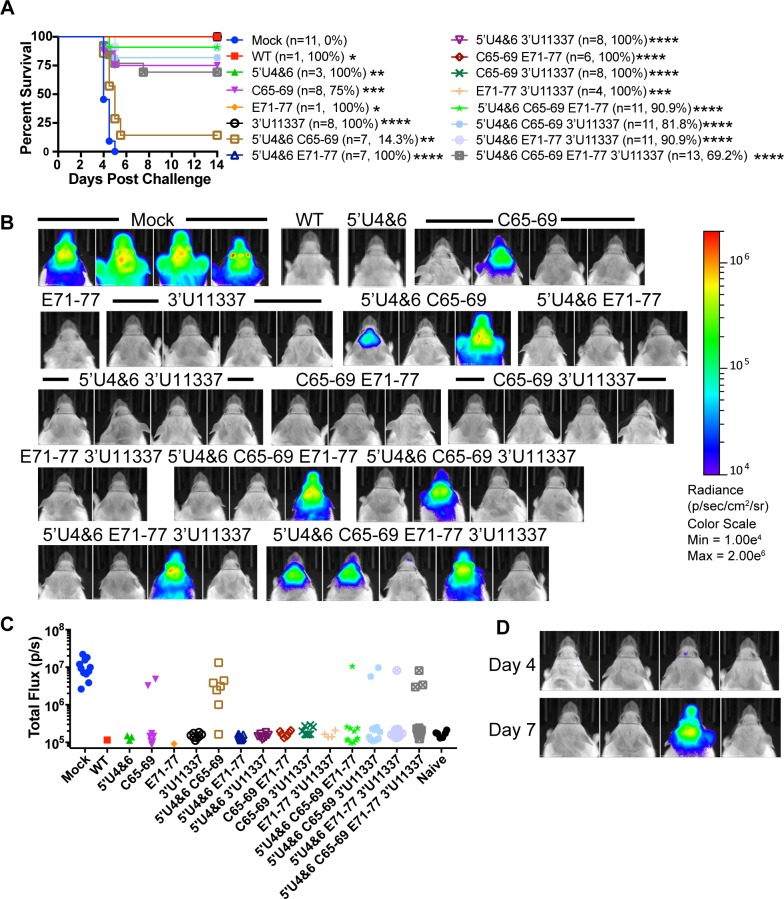
LAVs protect against an aerosol challenge.A) CD-1 mice that survived the primary LAV infection were challenged on D22 post primary infection. In parentheses are the numbers of mice surviving each LAV that were challenged by aerosol and the percent survival for each group. Mock mice were mock vaccinated controls for the experiment. 3 independent aerosols were performed using 100LD50 EEEV expressing nLuc. Calculated doses for each aerosol were 73,554 pfu,96,118 pfu, and 78,814 pfu. Only the triple mutant and quadruple mutant LAVs received the 78,814 pfu aerosol dose. *p<0.05, **p<0.01, ***p<0.001, ****p<0.0001, Log-Rank Test compared to mock. B) Representative IVIS images on day 4 of one aerosol challenge experiment. All IVIS images are set to the scale shown on right. C) Luciferase quantification of day 4 IVIS images represented as total flux (p/s). Naive mice were not challenged during the experiment and used for background total flux levels. D) IVIS images from 5’U4&6 C65-69 E71-77 3’U11337 LAV group on day 4 (top row) and day 7 (bottom row). All images in figure are set to the same scale (B).